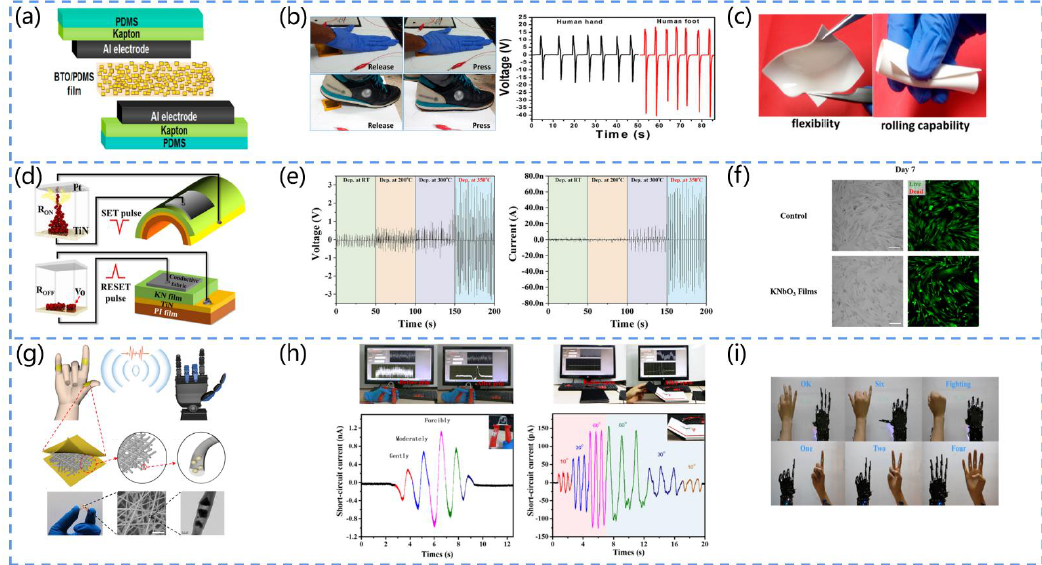
Figure 8. ( a ) Schematic diagram of the structure of the CPENG device. ( b ) Comparison of the voltages generated by the hand and foot release and the pressure applied to the CPENG. ( c ) Photo showing the excellent flexibility and rolling ability of the film. Reprinted with permission from [100]. Copyright 2017, ACS Publications. ( d ) Schematic diagram of the structure and operation of the KN-PENG. ( e ) Piezoelectric output generated by KN membranes formed at different temperatures used for the preparation of the PENG. ( f ) Comparison of the survival rates of human dermal fibroblasts on cell culture plates and on KNbO 3 membranes over 7 days (Green and red colors indicate live and dead cells, respectively). Reprinted with permission from [101]. Copyright 2017, ACS Publications. ( g ) Structure of a self-powered piezoelectric sensor based on cowpea-structured PVDF/ZnO nanofibers. ( h ) Detection of the grip force and angle of book opening and closing by the piezoelectric current signal. ( i ) Application of sensors in gesture remote control. Reprinted with permission from [102]. Copyright 2019, Elsevier.